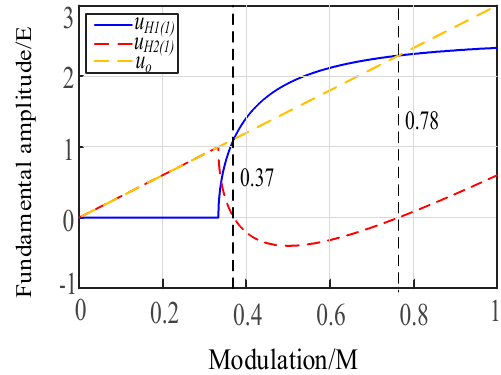
Figure 4. The relationship between the amplitude of the fundamental wave and the modulation index M.